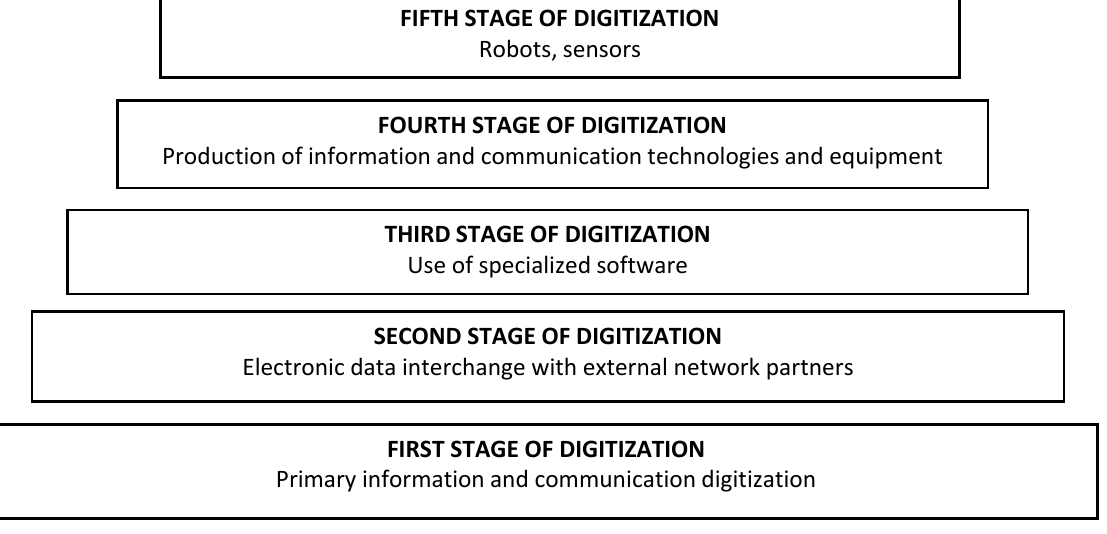
Figure 1. Digitalization process of the industrial